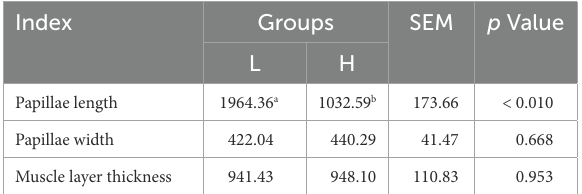
TABLE 4 Effects of MR levels on the rumen ruminal histomorphology of lambs.